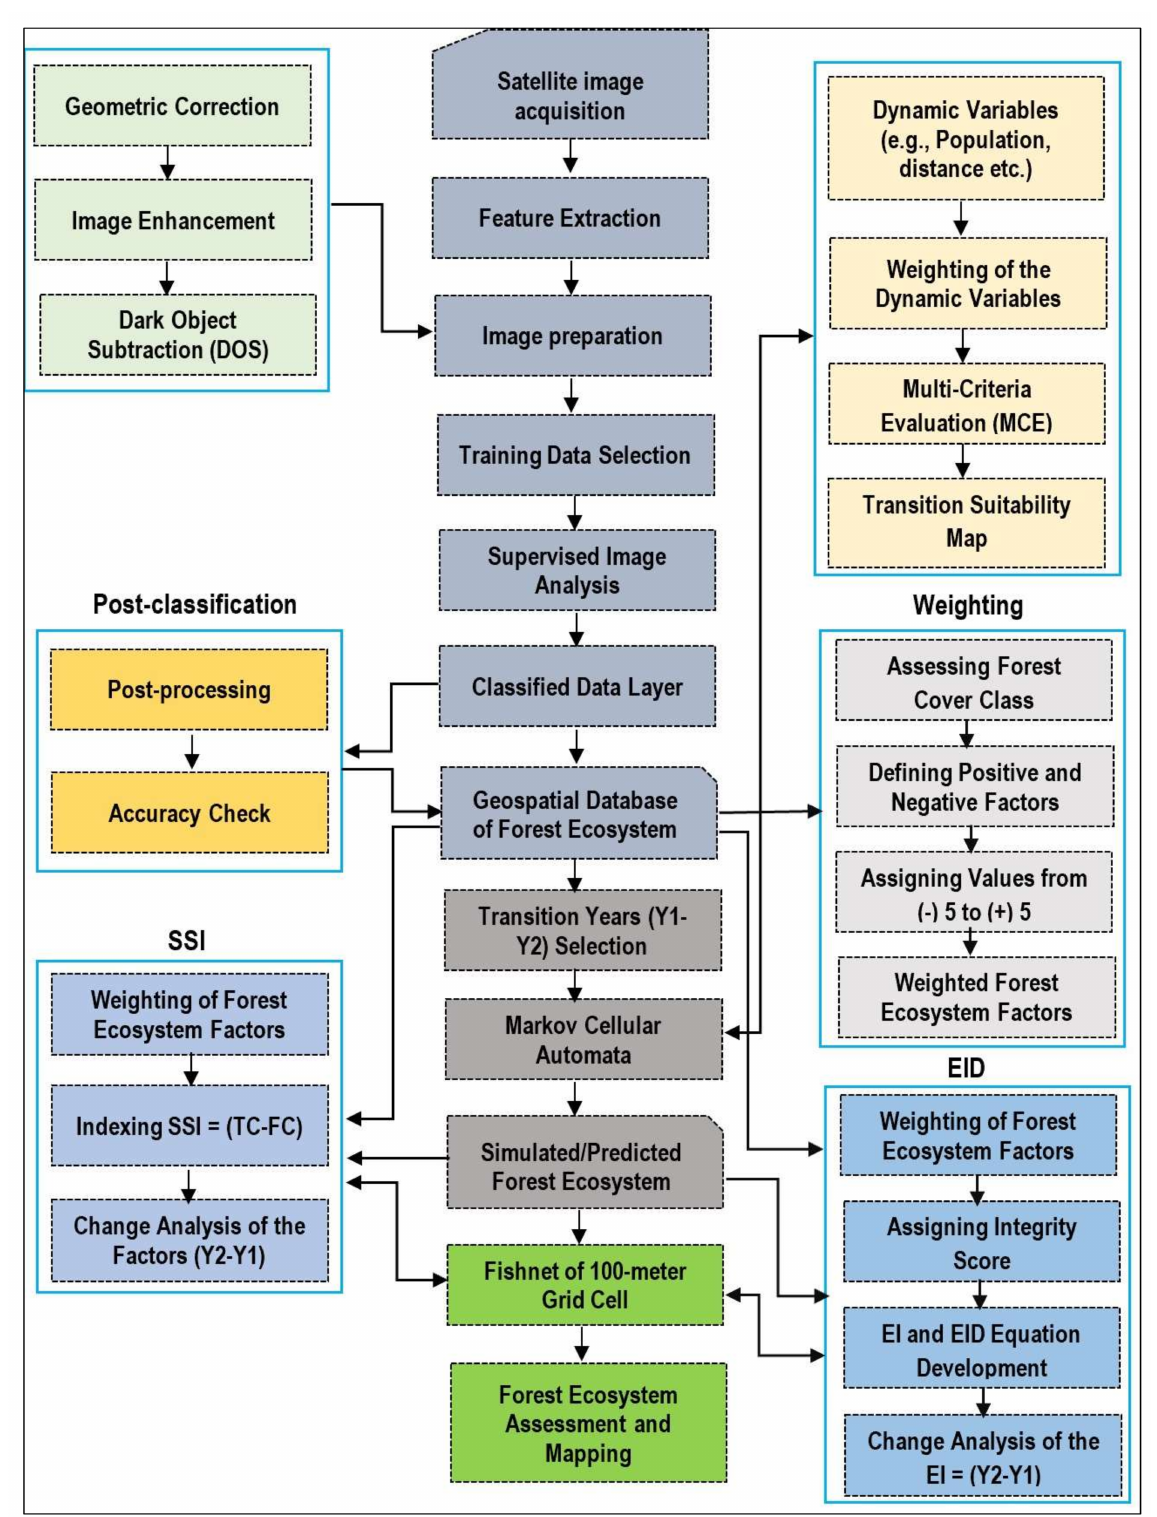
Figure 5. Methodological flowchart for the derivation of land use and forest cover, modeling of the forest ecosystem, and assessment of the forest ecosystem degradation and depletion based on the anthropogenic